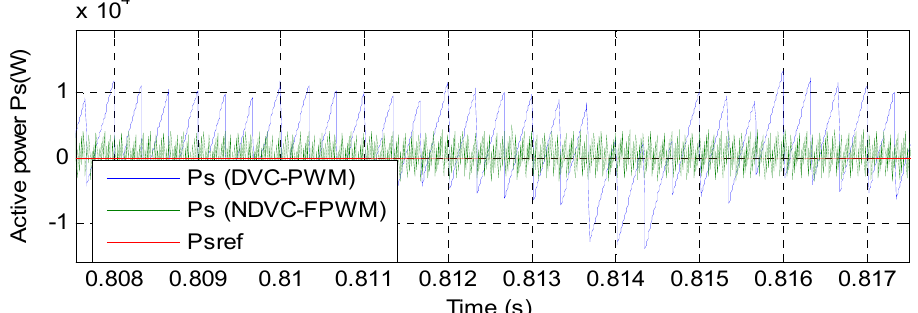
Figure 19. Stator current.